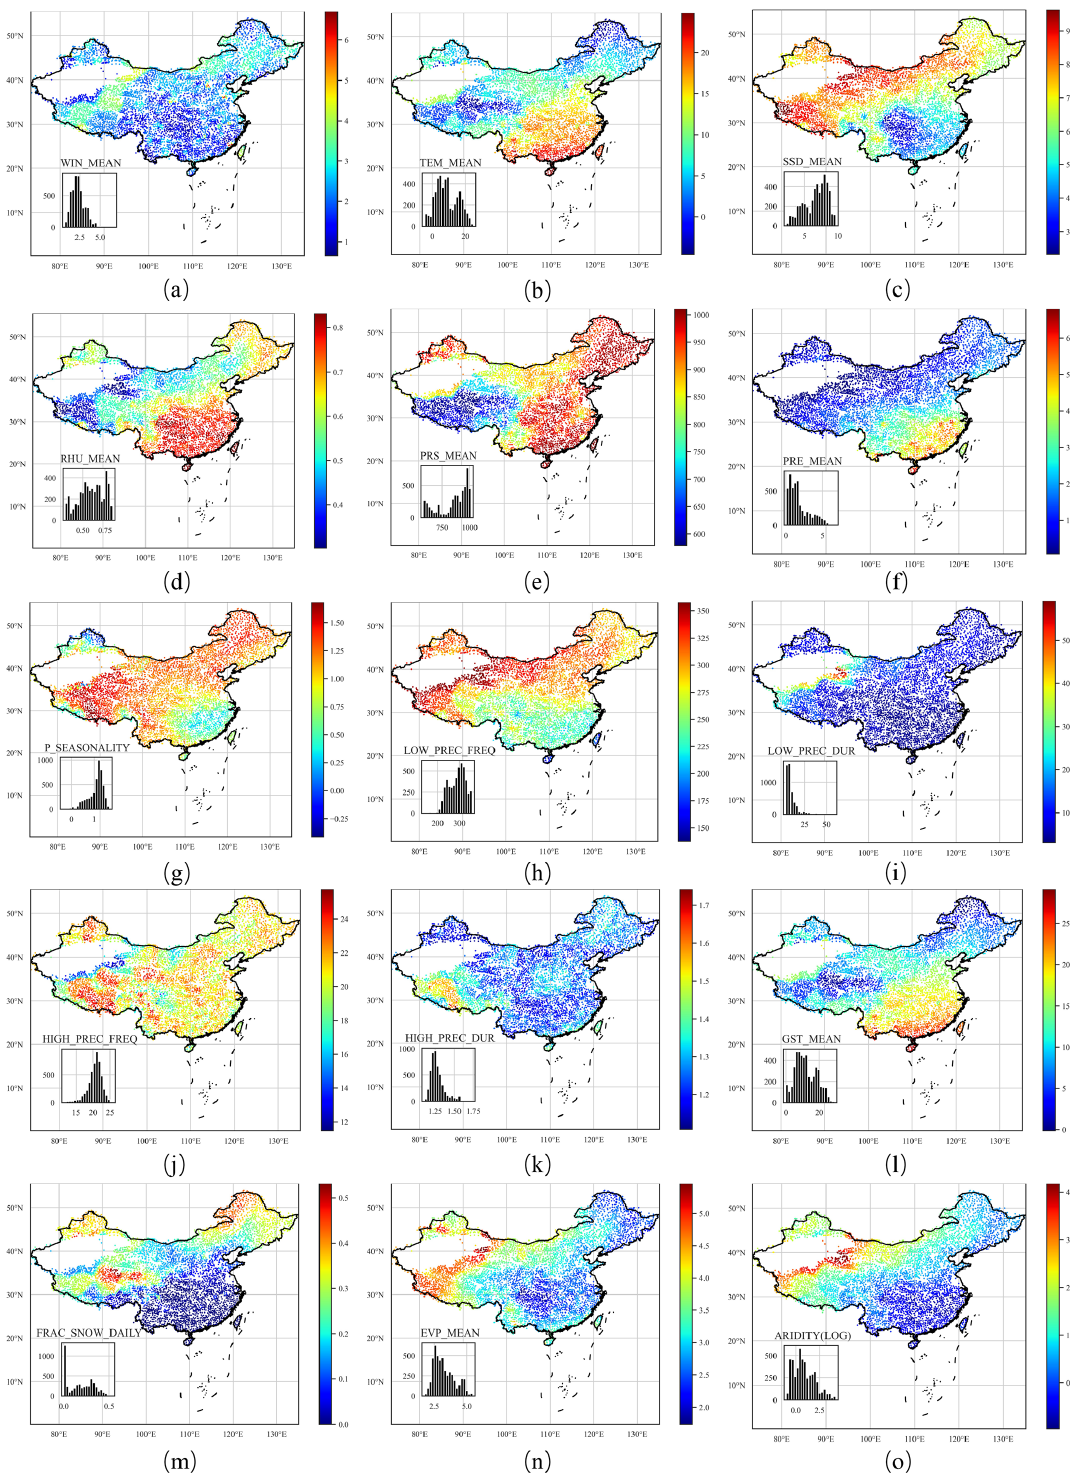
Figure 3. Distributions of climatic indices throughout China. All basins are plotted in the same size. When extreme values of a variable affect visualization (causing most areas to have the same color), the log values are used for visualization.